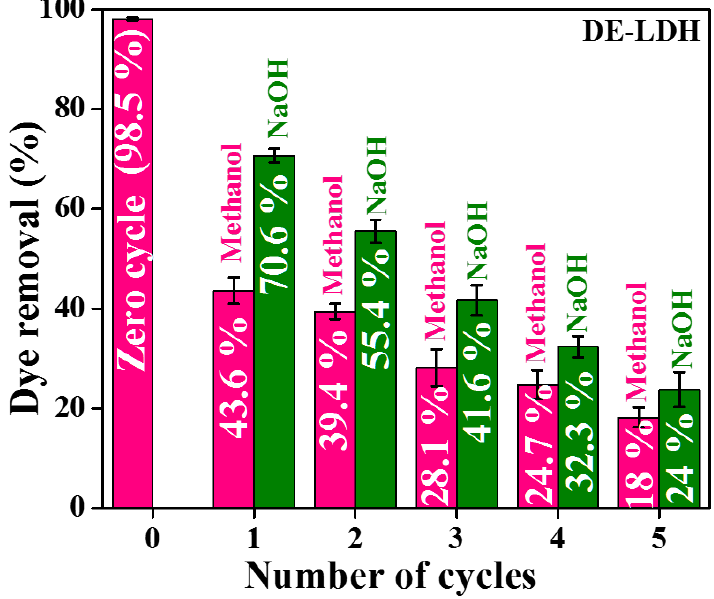
Figure 12. Reusability of DE-LDH for the adsorption of CR.